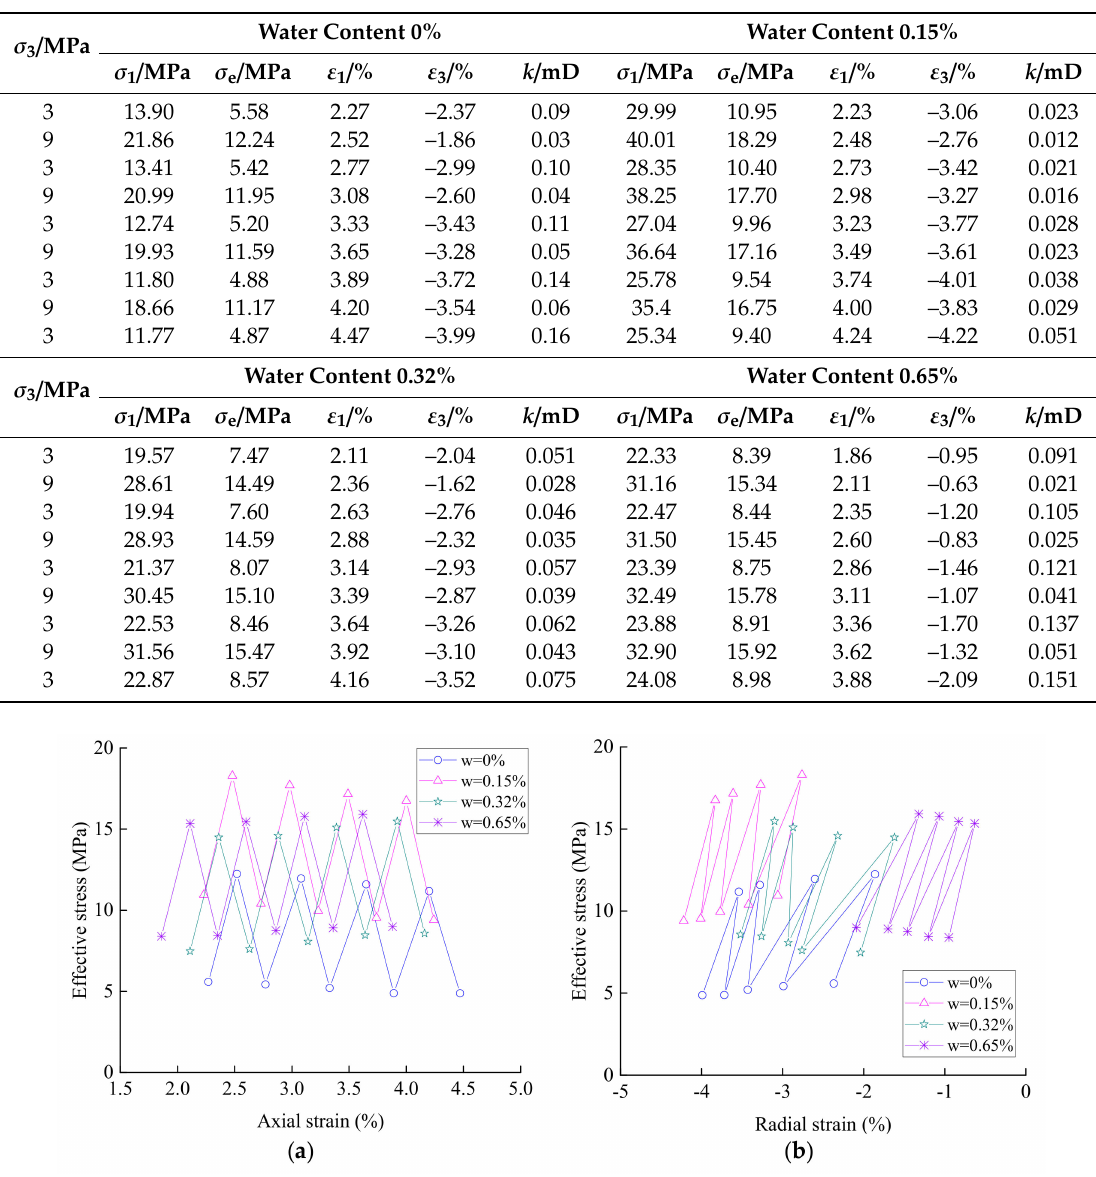
Table 2. Deformation parameters of each sample with di ff erent stress.